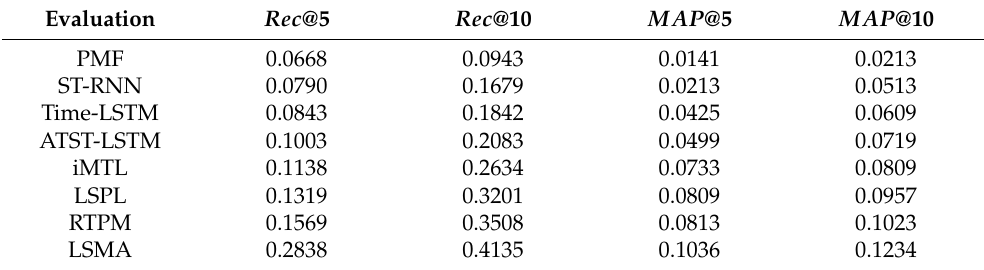
Table 1. The recommendation result of different methods for the CHA dataset.